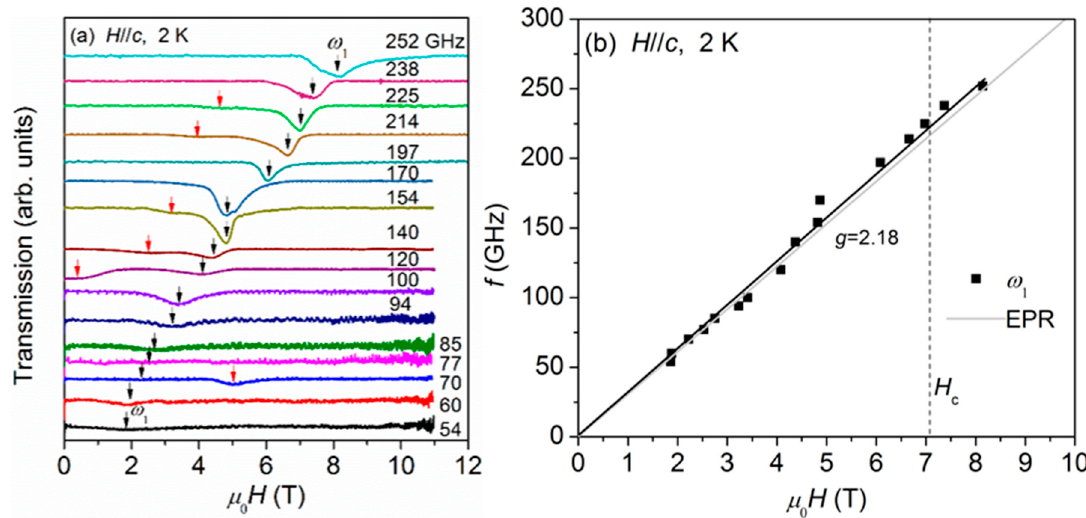
Figure 7. ( a ) Frequency-dependent ESR spectra measured at 2 K for the hard c axis. ( b ) Frequency-field ( f ‒ H ) relationship at 2 K as well as the EPR line. The solid line is a guide for the eyes.